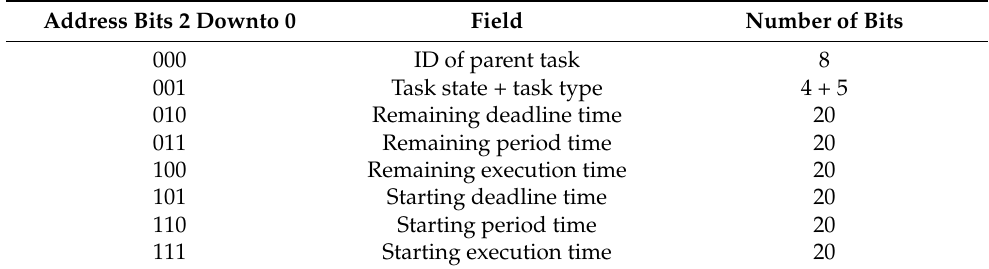
Table 2. Memory map of Tasks Memory.